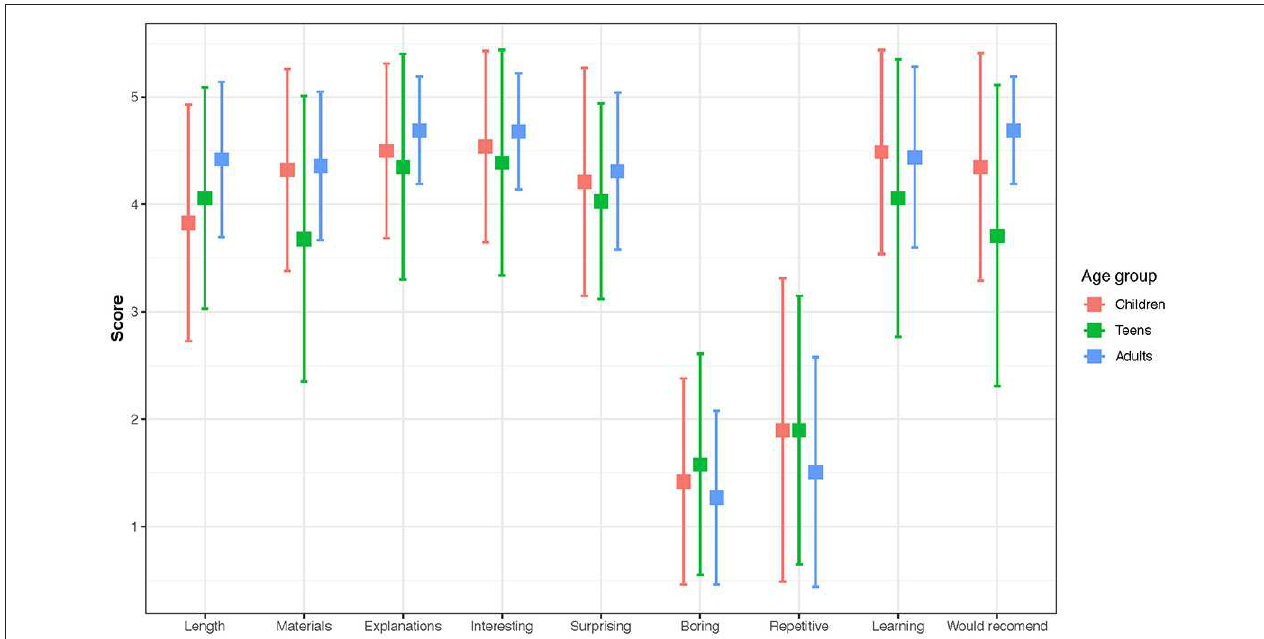
FIGURE 4 | Results (avg. ± s.d.) of the nine closed-ended survey questions among the three different age groups: under 12 years of age, ( n = 219), teenagers aged 12–17 ( n = 33) and adults ( n =